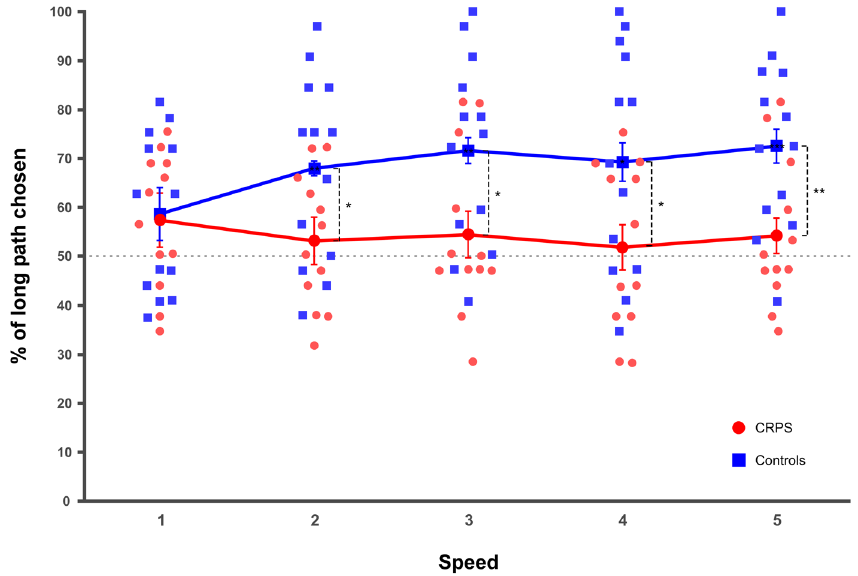
Figure 6. Mean percentage of the long path chosen for the different speed (1 to 5). CRPS patients are represented in red circles and control participants in blue squares. Smaller and lighter colored circles/squares represent the individual data. Error bars indicate the 95% confidence intervals adapted according to the method of Cousineau 69 . Asterisks in squares indicate t tests significantly different from 50. *p ≤ 0.05, **p ≤